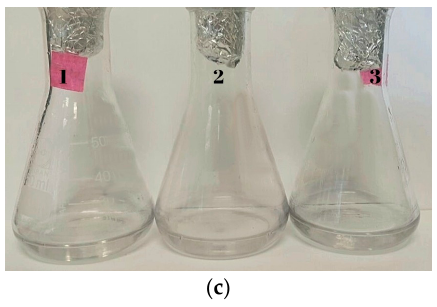
Figure 3. Bioassays of possible formation of gold nanoparticles with living cells for the strains ( a ) CBAM5 alone, ( b ) mix of MCB1 and MCB2 and, ( c ) control after 48 h. The numbers in the flasks are the replicates for each bioassay.